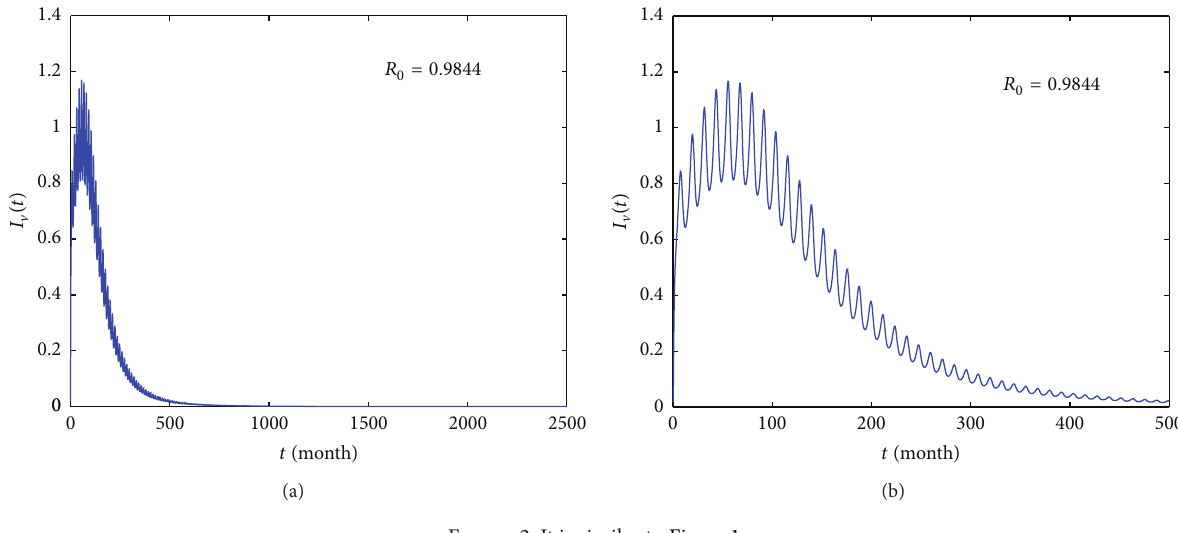
Figure 2: It is similar to Figure